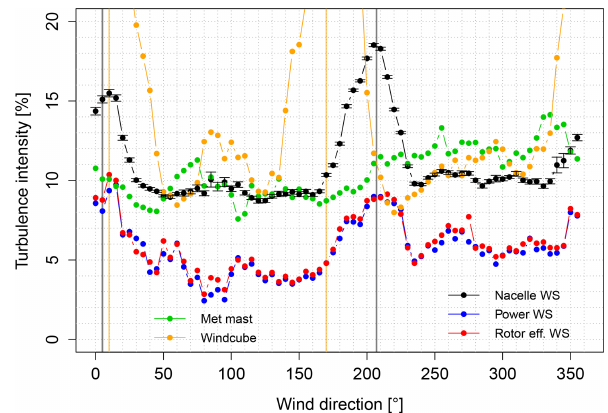
Figure 4. Comparison of TI measurements at SMV5 (for nacelle wind speed, power wind speed and rotor effective wind speed) and at external sensors (met mast and Windcube), represented against wind direction. Error bars shows the 68% normalized confidence interval (represented for NWS but a same order of magnitude can be expected for other sensors in the same wind direction bin). Vertical lines indicate position of wakes for SMV5 sensors and